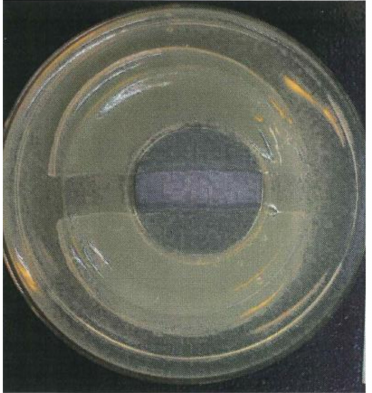
Figure 12. Appearance of Plasma Indicator TM put in configuration (5).